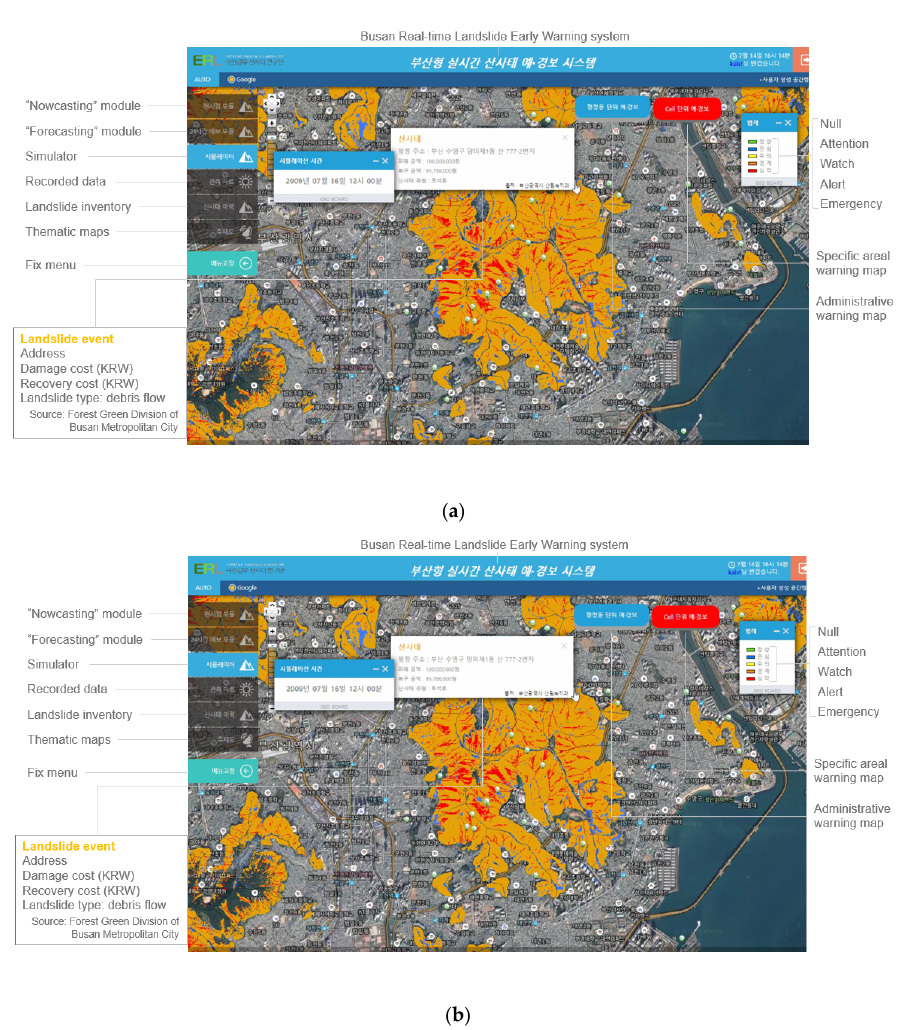
Figure 3. Two di ff erent types of landslide early warning level maps obtained from a landslide early warning system based on the sequential evaluation method including ( a ) a specific areal warning map and ( b ) an administrative warning